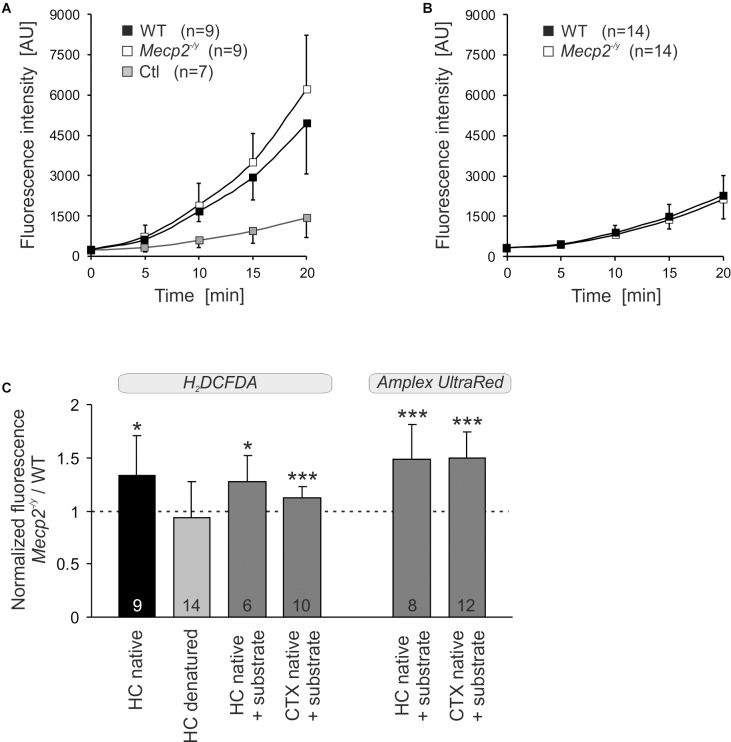
Increased ROS release from mitochondria of Mecp2-/y hippocampus and cortex. (A) ROS generation was quantified in mitochondrial suspensions under native conditions (assay buffer without substrates) using the oxidation-sensitive dye H2DCFDA. Genotypic comparison reveals an increased ROS formation by mitochondria from Mecp2-/y hippocampus. The control cuvettes (Ctl) contain buffer plus dye only and report the extent of photo- and autoxidation of H2DCFDA during the course of this assay. (B) In contrast, under denaturing conditions, neither a pronounced oxidation of H2DCFDA nor a genotypic difference among WT and Mecp2-/y hippocampus was observed. This confirms that it is indeed the native mitochondria, which mediate the marked oxidation of H2DCFDA in this cuvette assay. (C) Also with the substrates malate, pyruvate, and succinate included into the assay buffer, mitochondria from Mecp2-/y hippocampus (HC) and cortex (CTX) released higher amounts of ROS than WT mitochondria (dashed line). This was confirmed unequivocally also with the more reliable reagent Amplex UltraRed. For comparison of the different conditions tested, the normalized fluorescence ratios are plotted, by referring Mecp2-/y responses to the respective WT conditions. The number of samples (mice) analyzed is reported; asterisks mark statistically significant differences as compared to WT (one sample t-tests; ∗p < 0.05, ∗∗∗p < 0.001).